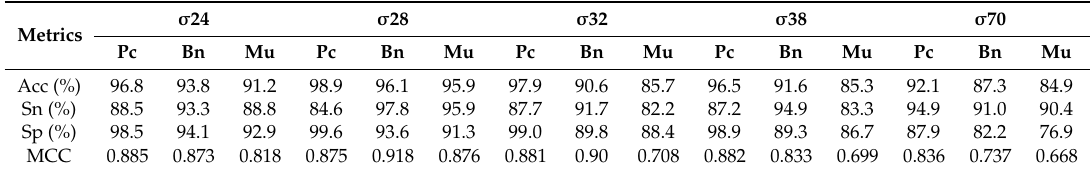
Table 5. Sigma promoter performance comparison. ‘Pc’ represents the results of proposed architecture, ‘Bn’ represents the results of iPromoter-BnCNN, ‘Mu’ represents results of MULTiPly architecture. σ 24 σ 28 Metrics